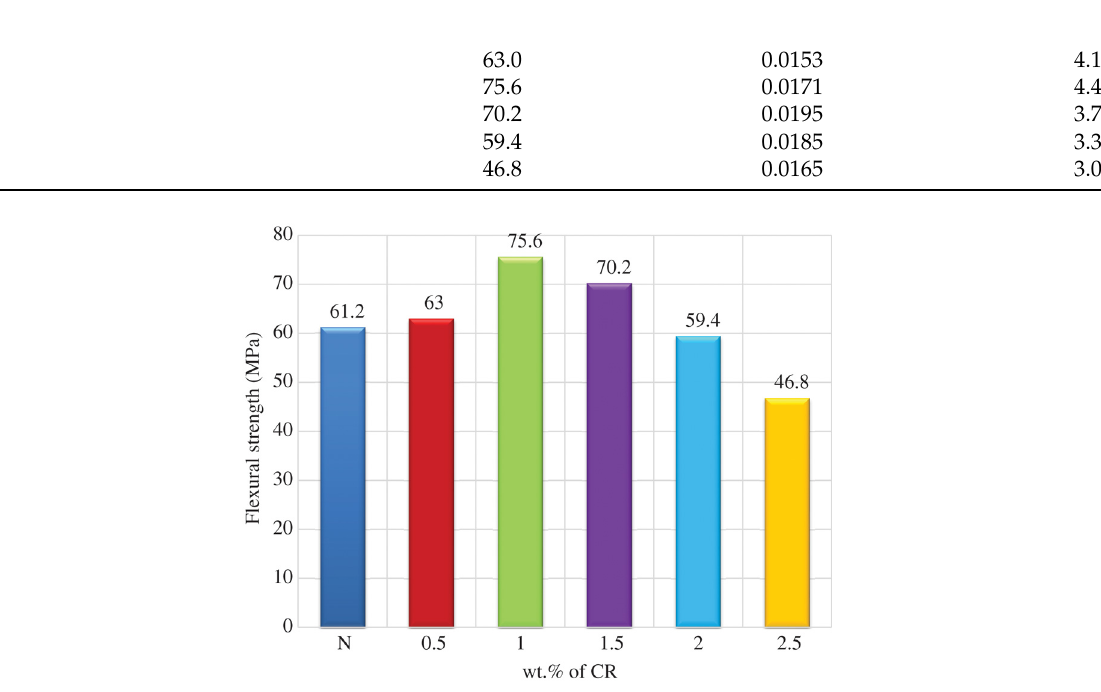
Figure 25: Flexural strength for various compositions of CFR composite.